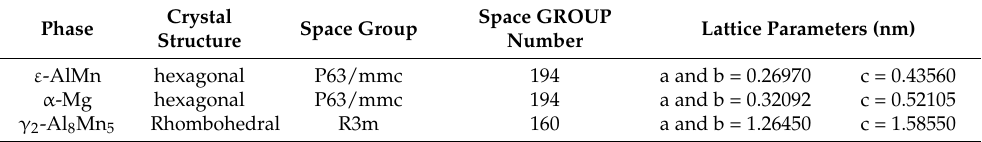
Table 3. The crystal structures for γ 2 -Al 8 Mn 5 , ε -AlMn, and α -Mg data from [33,35]. Crystal Space GROUP Phase Space Group Lattice Parameters (nm) Structure Number ε -AlMn